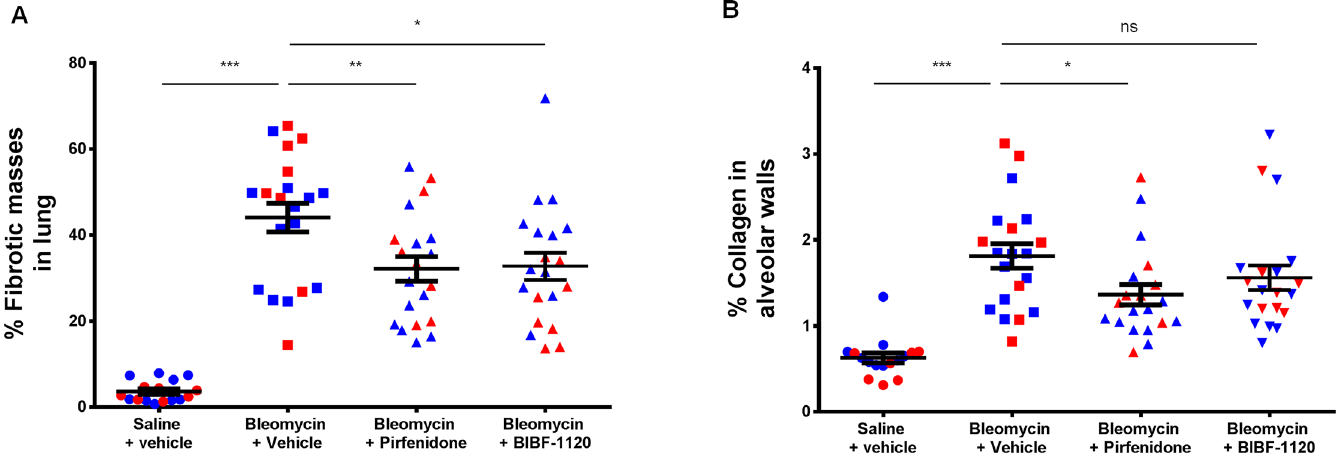
Fig 4. Quantitative analysis of anti-fibrotic compound effects. Lungs from Wistar rats treated with bleomycin in combination with pirfenidone (0,50%) and BIBF- 1120 (50mg/kg) were collected at Day 14 and a Masson’s trichrome staining was performed for fibrosis parameter assessment using automated image analysis. A : percentage of fibrotic masses, B : percentage of alveolar collagen. Mean with +/- SEM, Mann-Whitney statistical test. Each dot represents an individual animal and color represents independent studies. Study 2 in red, and study 6 in blue.